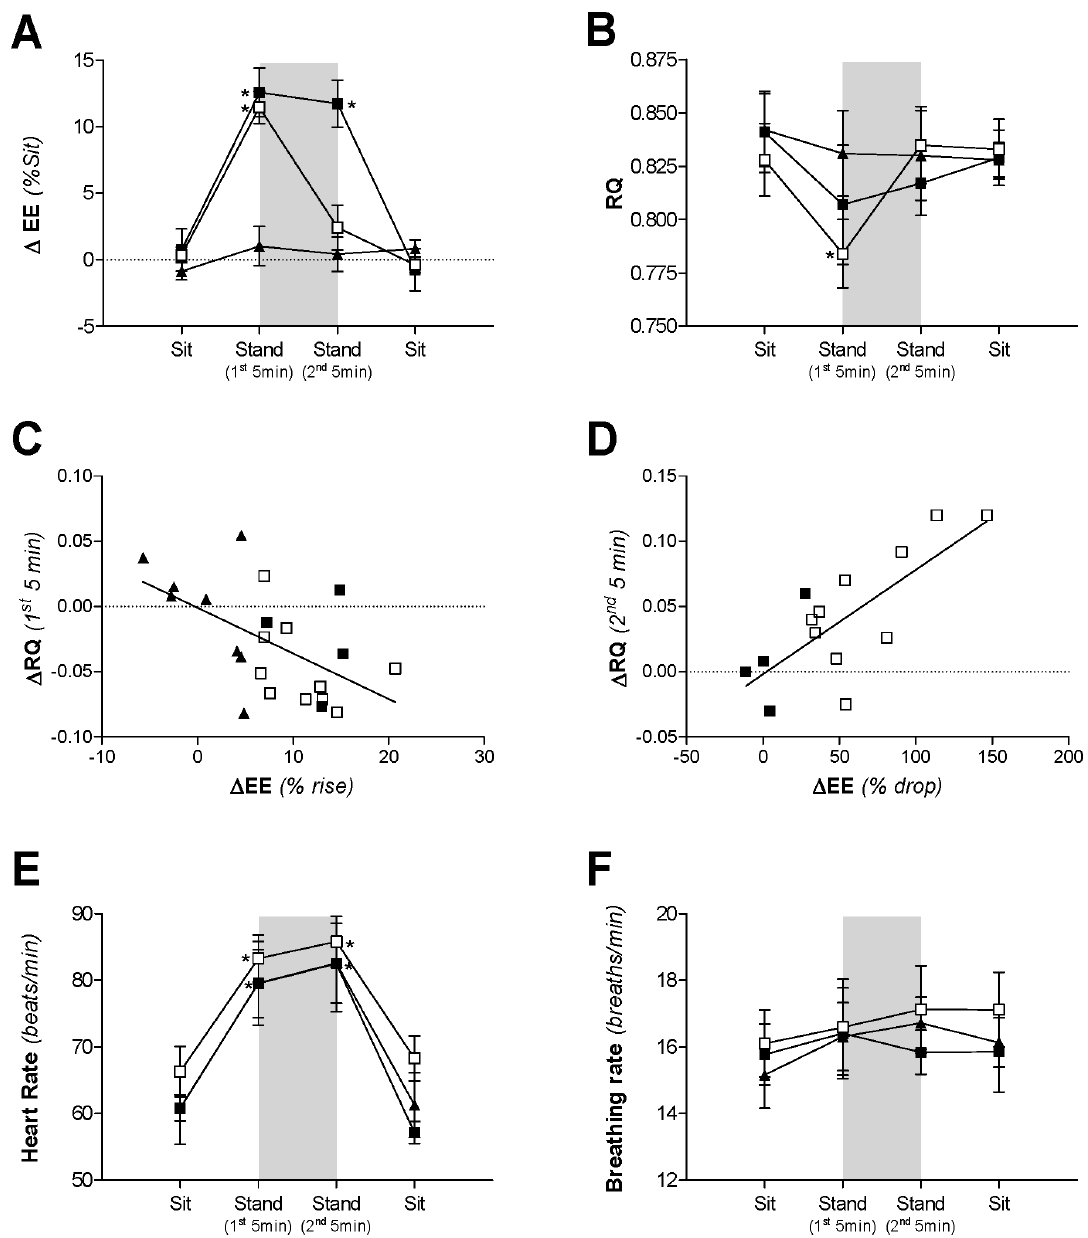
Figure 3. Comparison of energy expenditure, heart rate and breathing rate. Comparison of mean 6 SEM energy expenditure (EE, Panel A), RQ (Panel B), heart rate (beats/min, Panel E), and breathing rate (breaths/min, Panel F) for each EE response group: Non-Responders ( m ), Responder Droppers ( % ), Responder Non-Droppers ( & ). The shaded area indicates the steady-state standing period. *statistically significant from baseline as assessed by repeated-measures ANOVA followed by Dunnett’s multiple comparison tests. Panels C and D indicate the relationships between the change in RQ vs change in EE during the first 5 min (percentage ‘‘rise’’ from sitting value, Panel C), as well as vs change in EE during the second 5 min (percentage ‘‘drop’’ to sitting value, Panel D) of the 10 min steady-state standing period. D EE (% rise) vs D RQ (1 st 5 min): r=0.56, p , 0.02; D EE (% drop) vs D RQ (2 nd 5 min): r=0.77, p=0.001. Non-Responders ( m ), Responder Droppers ( % ), Responder Non-Droppers ( & ).